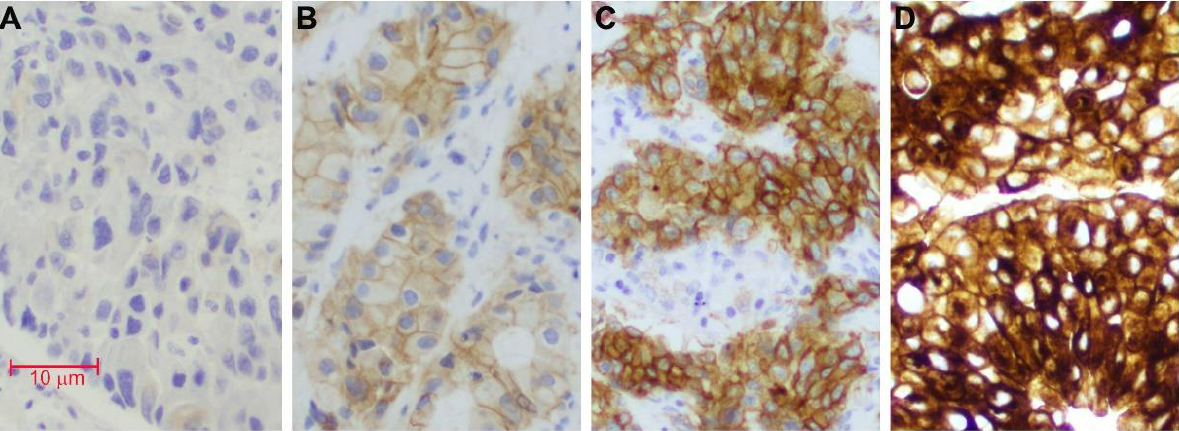
Figure 2. MET expression level by immunohistochemistry stain (×20). ( A ): Absent (0+); ( B ): Weak (1+); ( C ): Moderate (2+); ( D ): Strong (3+).